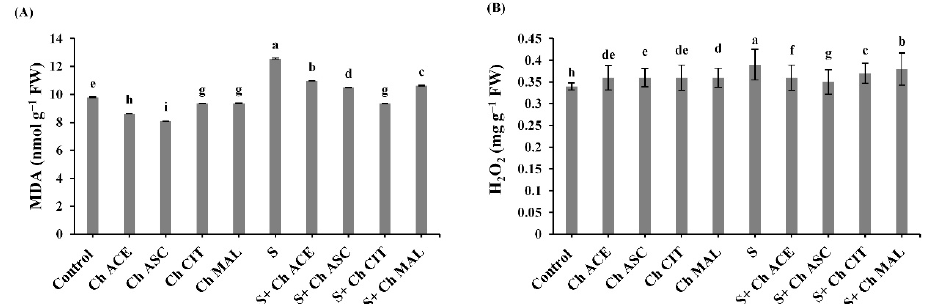
Figure 5. Effect of salinity (S) and foliar application of chitosan dissolved in different organic acids (Ch ACE, Ch ASC, Ch CIT and Ch MAL) and their interactions on ( A ) Malondialdehyde (MDA) and ( B ) Hydrogen peroxide (H 2 O 2 ) of tomato plants. Data are presented as means ± SE (n = 3). Data followed by different letters are significantly different following Tukey’s honestly significant difference (HSD) test at p ≤ 0.05. FW: fresh weight.